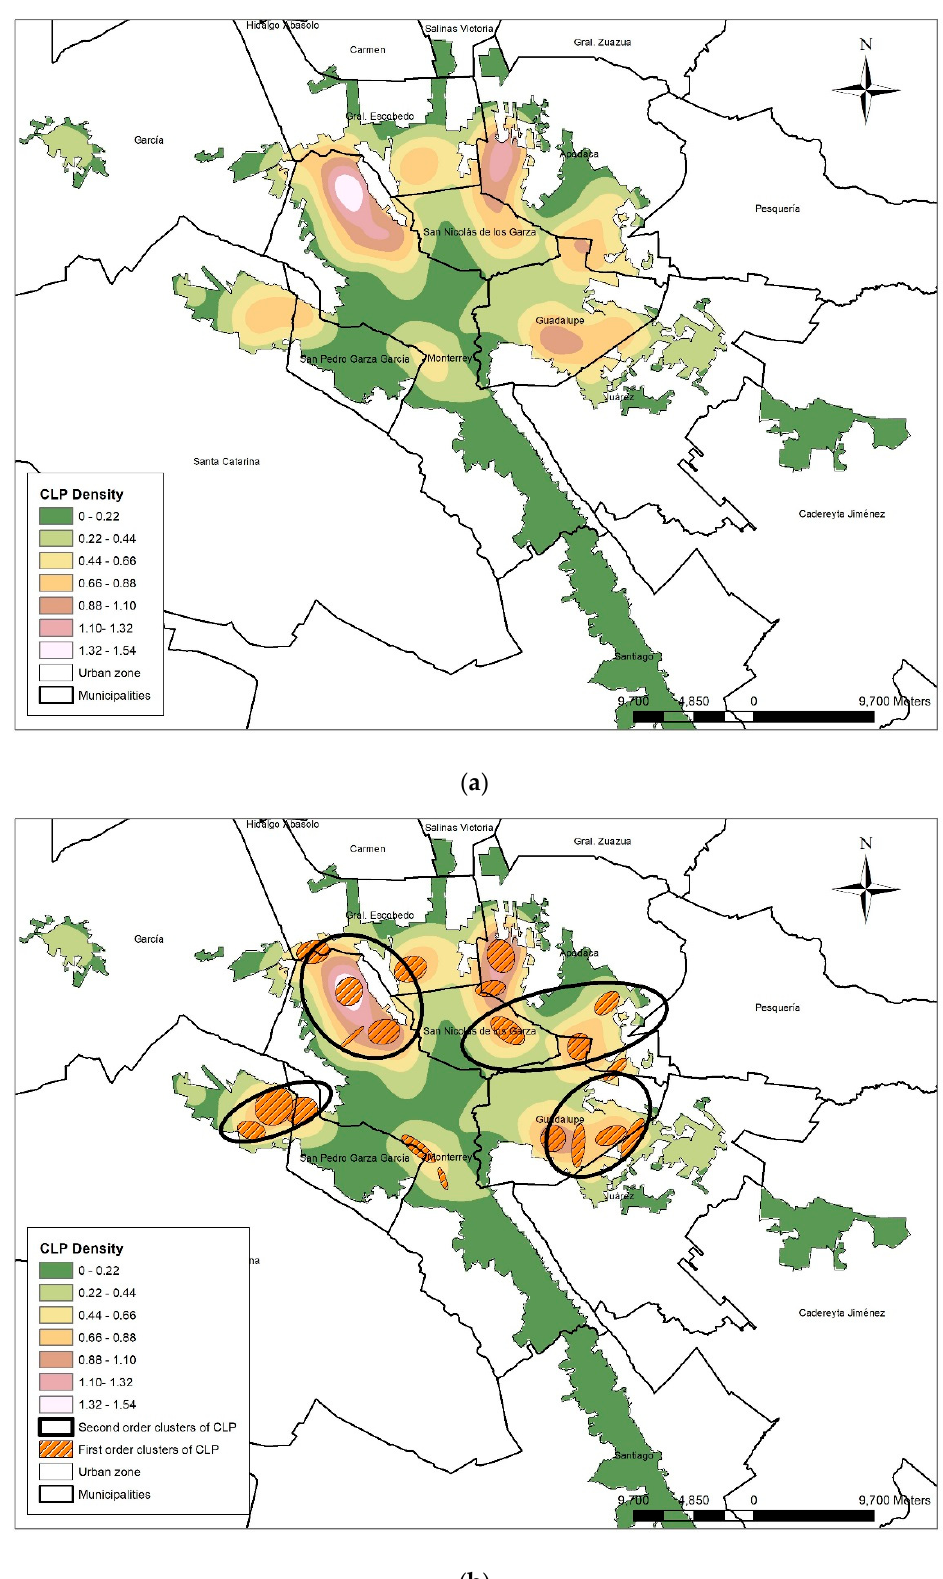
Figure 3. Spatial distribution of cleft lip and palate (CLP) in the Metropolitan Area of Monterrey. ( a ) Density; ( b ) Clusters.